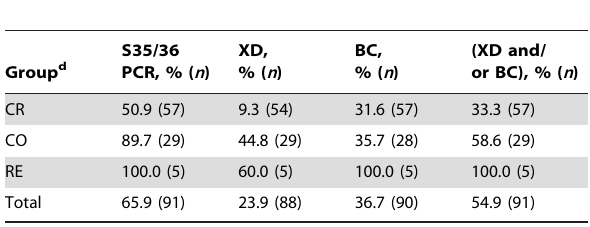
Table 1. Sensitivities of the qualitative PCR a , xenodiagnosis b and blood culture c in Chagas disease with/without HIV